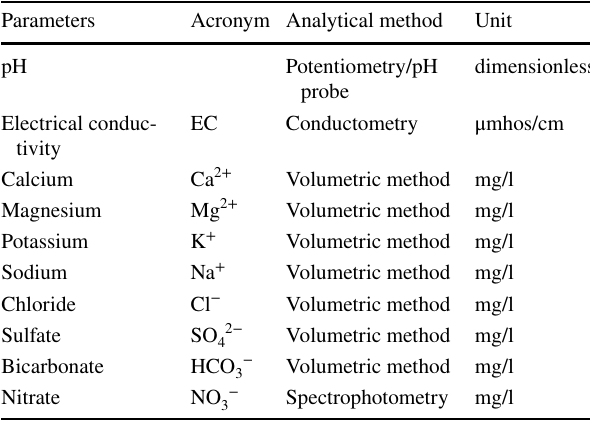
Table 1 Represents the groundwater quality parameters and